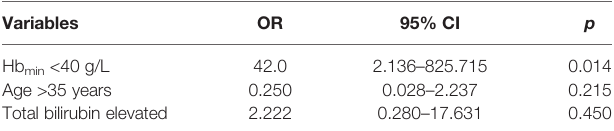
( Table 2 ). Validation via contingency table and Kruskal – Wallis ANOVA test con fi rmed this implication (Spearman value = 0.732; p = 0.002).